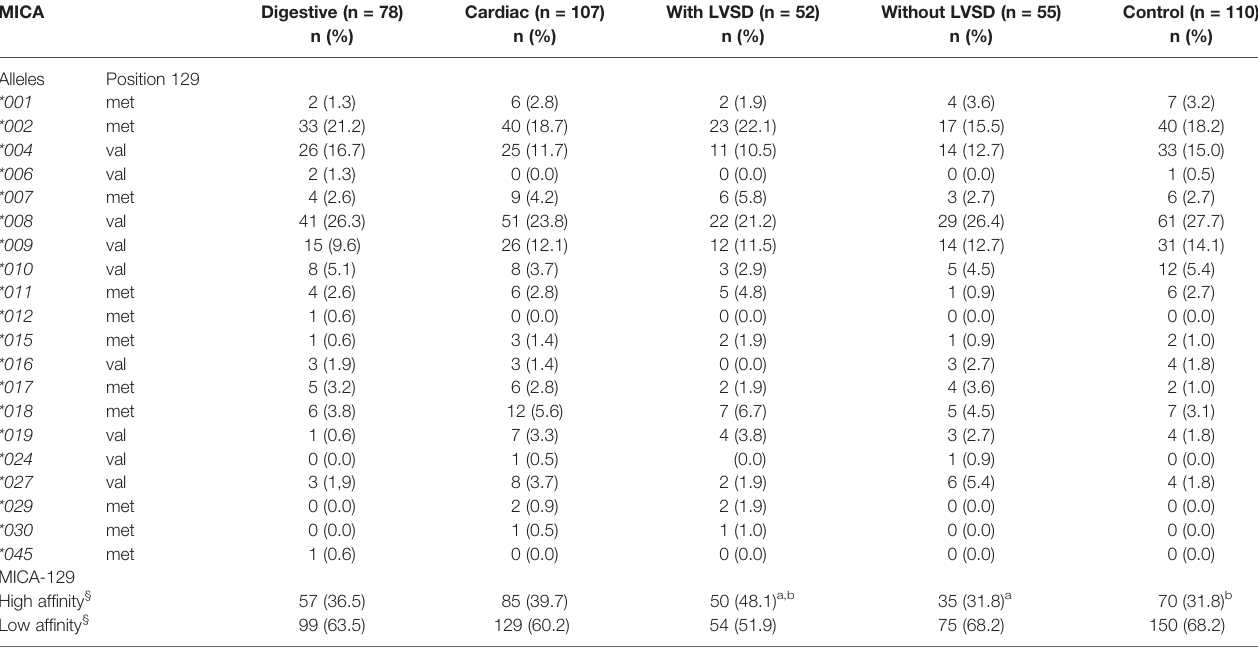
TABLE 2 | Distribution of MICA alleles in patients with the digestive or cardiac forms of chronic Chagas disease, in patients with LVSD and without LVSD and in control individuals.